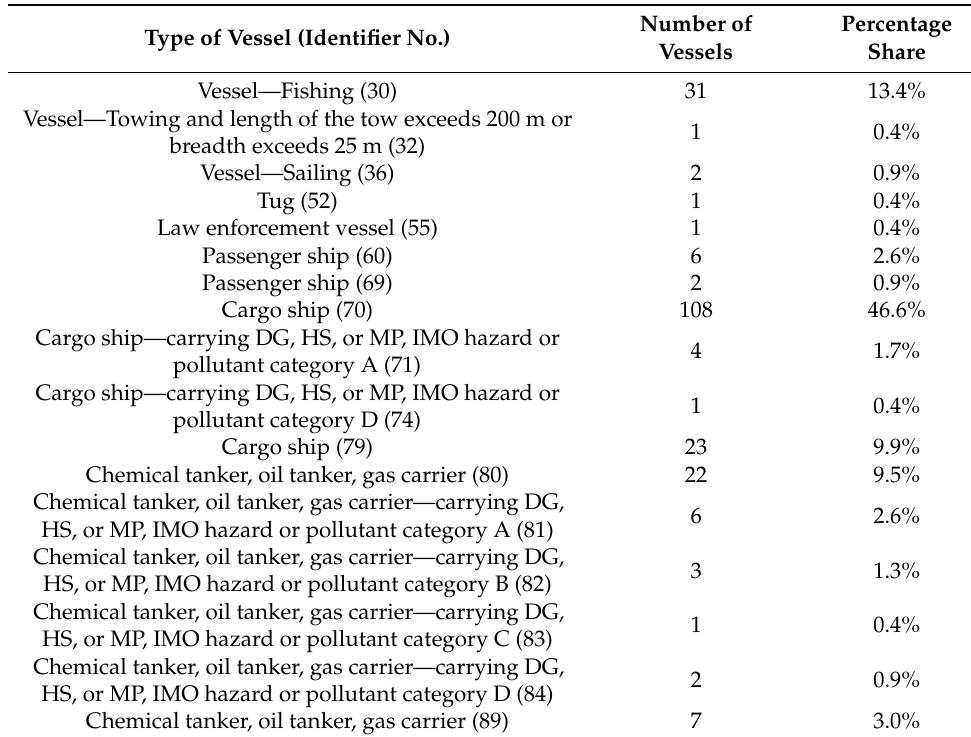
Table 11. List of ships on the 2-2 measurement profile, broken down by type.